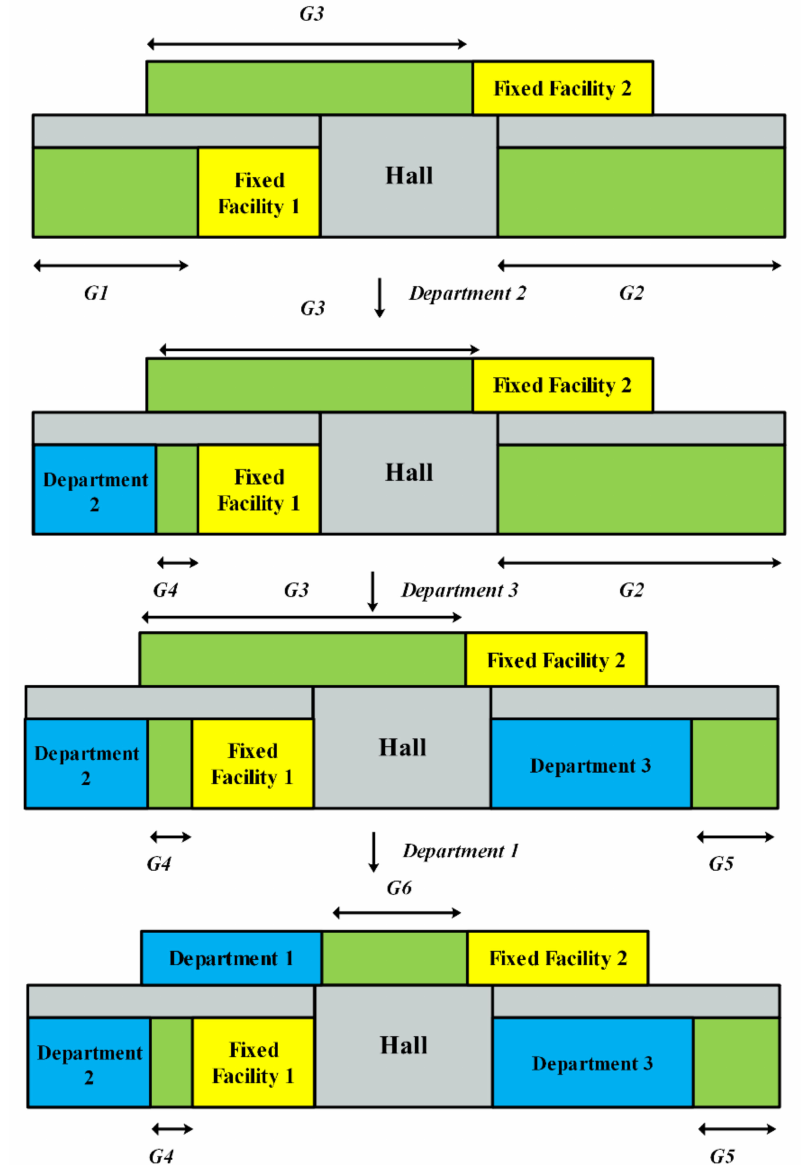
Figure 2. An example of a construction